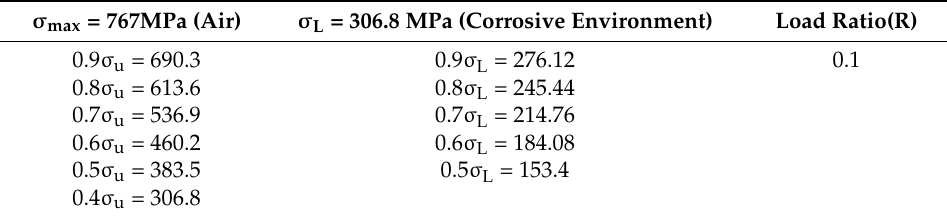
Table 3. Fatigue test conditions in the air and in a corrosive environment.